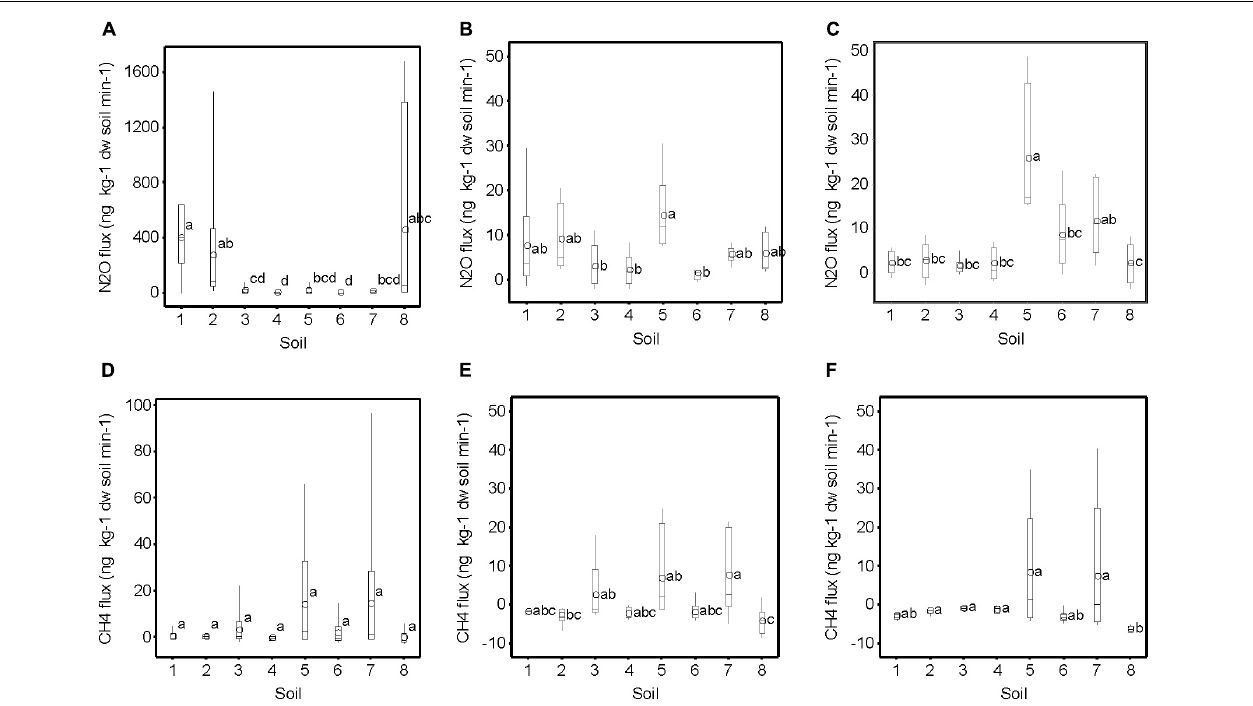
FIGURE 1 | Soil nitrous oxide (N 2 O) fluxes (ng kg − 1 dry soil min − 1 ) at (A) near water-saturated conditions, (B) 0.5 m water column, and (C) 1.0 m water column; and (D–F) methane (CH 4 ) fluxes at the respective soil water suction heads. Different letters denote significantly different values of the mean (open circle, n = 7, p < 0.05). Note the different